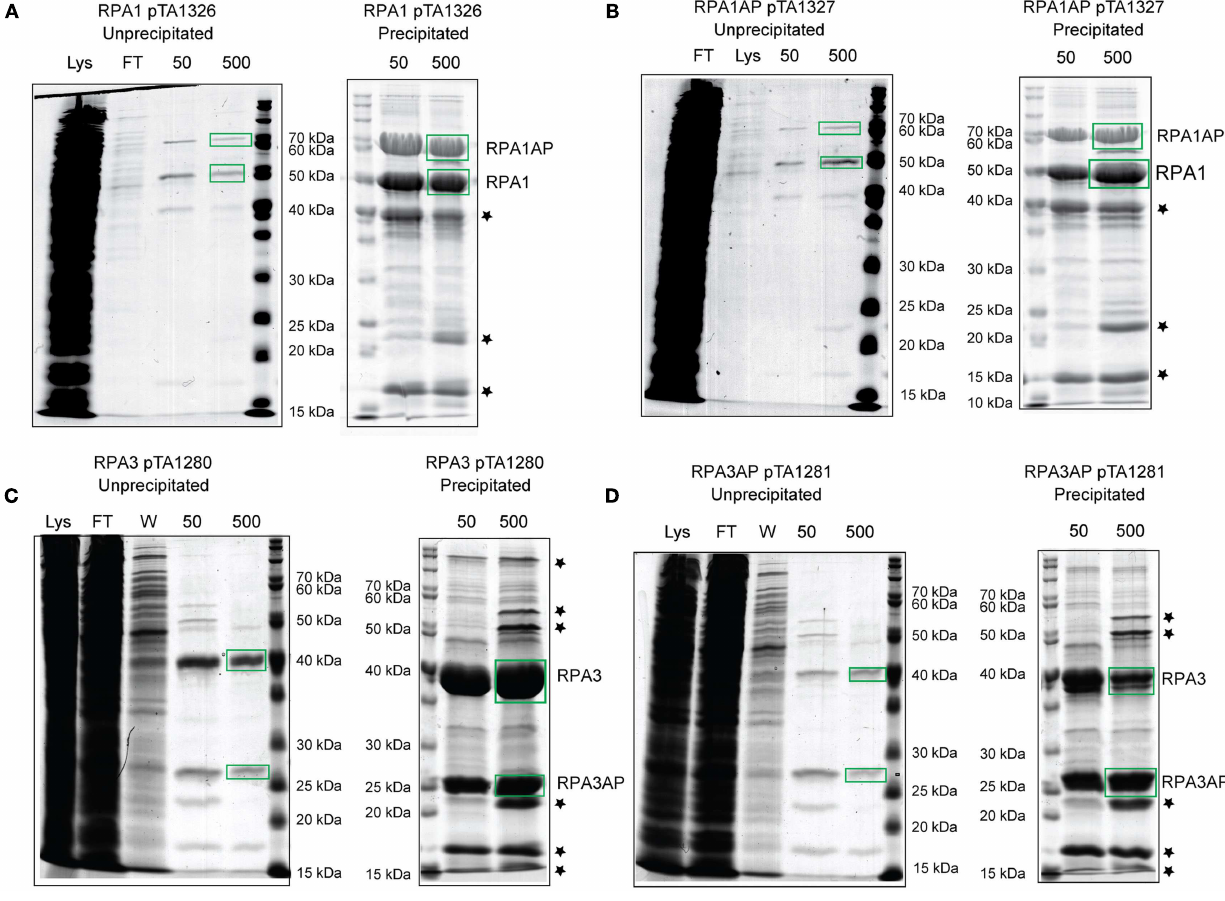
FIGURE 6 | H. volcanii strains containing (A) histidine-tagged RPA1 (H1482), (B) histidine-tagged RPAP1 (H1483), (C) histidine-tagged RPA3 (H1480), and (D) histidine-tagged RPAP3 (H1481) were used in protein overexpression. The histidine-tagged recombinant proteins were purified from the soluble fraction (lysate) by affinity chromatography on a Ni 2 +